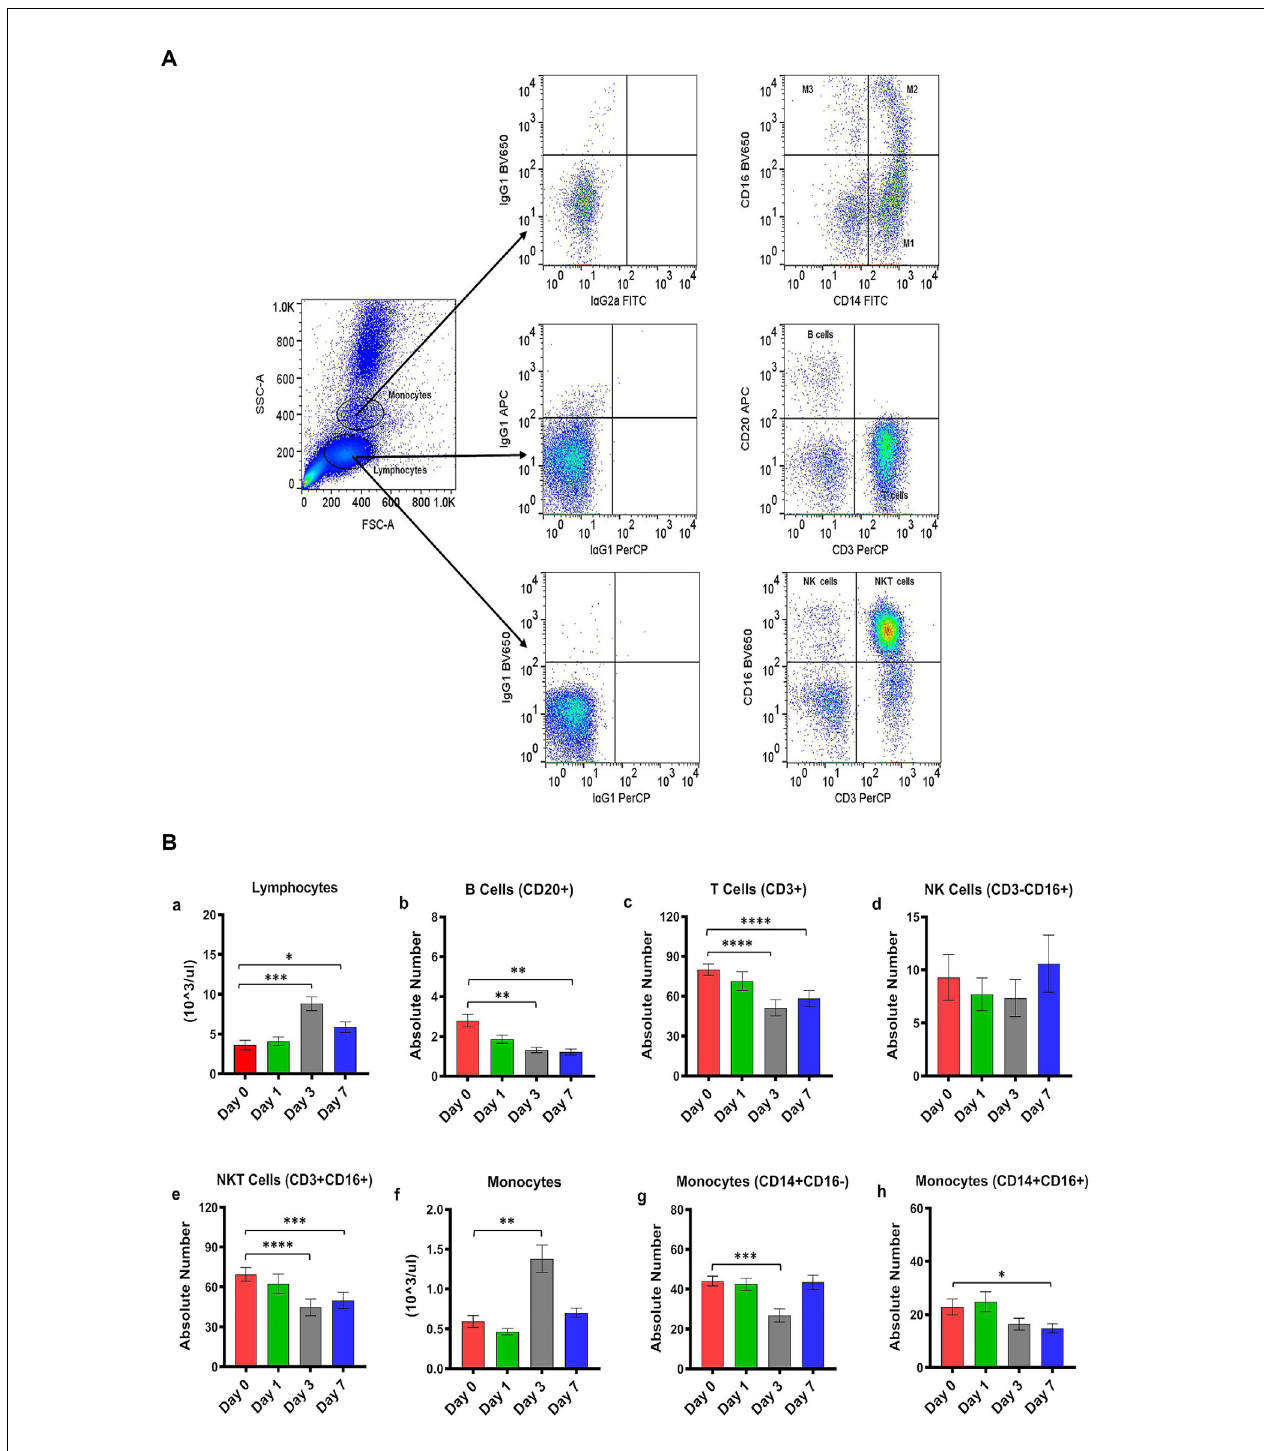
FIGURE 1 | (A) Gating scheme for identification of the various cell markers in the peripheral blood. The lymphocytes and monocytes were first gated based on forward scatter (FSC) vs. side scatter (SSC). CD3+ and CD20+ cells were positively identified by the lymphocyte gate while CD16+ and CD14+ cells were positively identified by the monocyte gate. The specificity of staining for the various markers was ascertained according to the isotype control antibody staining used for each pair of combination markers, as shown. (B) Changes in lymphocytes and monocytes populations in CpG ODN stimulated SQM peripheral blood across 7 days. Hematology analysis of lymphocyte ( a ) and monocytes ( f ) was performed on EDTA-preserved whole blood by using an automated analyzer, Advia (Siemens